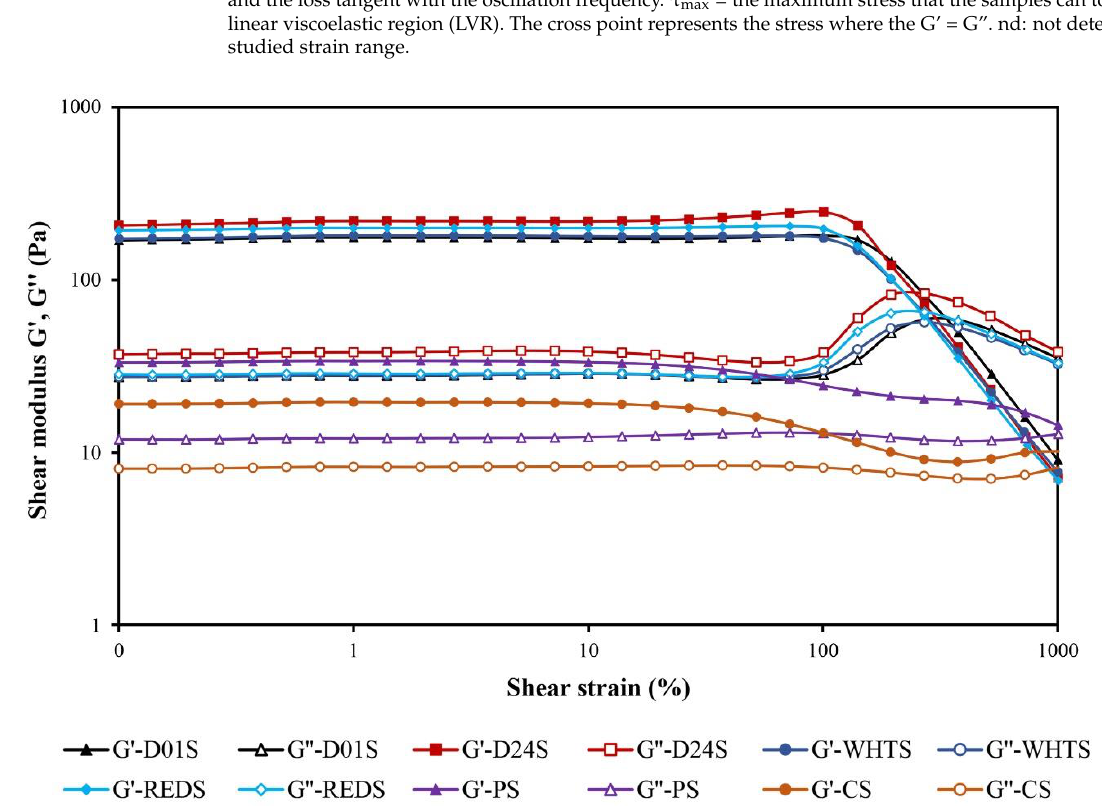
Figure 4. Strain sweeps of gels made with starches from four cultivars of anchote (D01S = Desta 01 starch, D24S = Desta 24 starch, WHTS = white starch, REDS = red starch), potato starch (PS), and cassava starch (CS). The elastic modulus, G′ , is represented using solid symbols and the viscous modulus, G″, with open symbols. Table 4. Rheological properties of anchote, potato, and cassava starches.